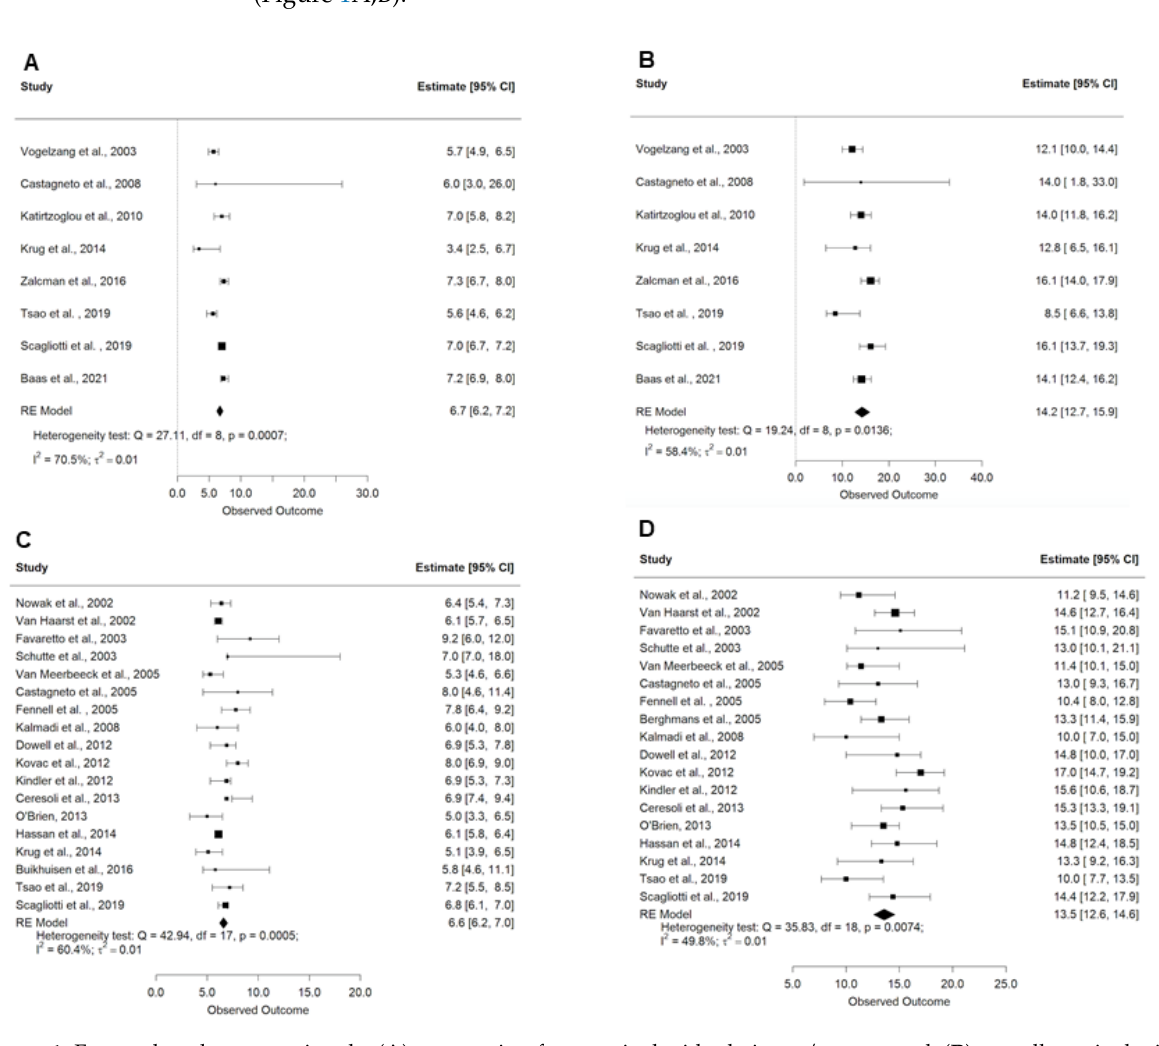
Figure 1. Forest plots demonstrating the ( A ) progression-free survival with platinum/pemetrexed; ( B ) overall survival with platinum/pemetrexed; ( C ) progression-free survival with other experimental therapies; and ( D ) overall survival with other experimental therapies. Squares indicate the proportions from individual studies and horizontal lines indicate the 95% confidence interval. The size of the data marker corresponds to the relative weight assigned in the pooled analysis using the random effects model. The diamond indicates the pooled proportion with 95% CI.